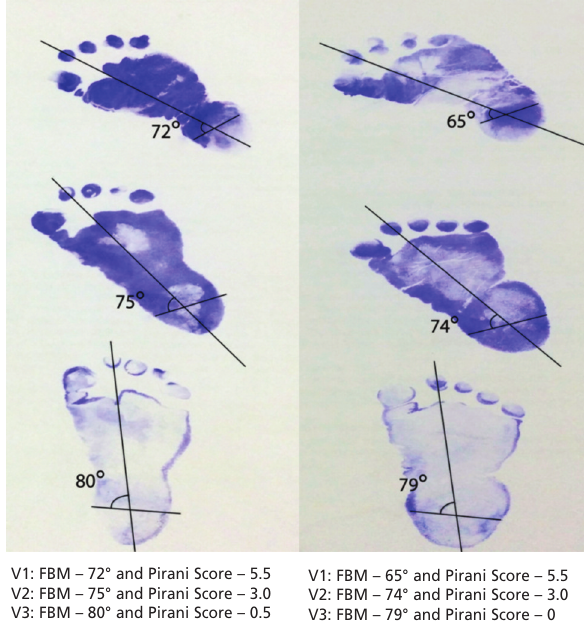
Osteocartilaginous relationship on medial Fig. 2: